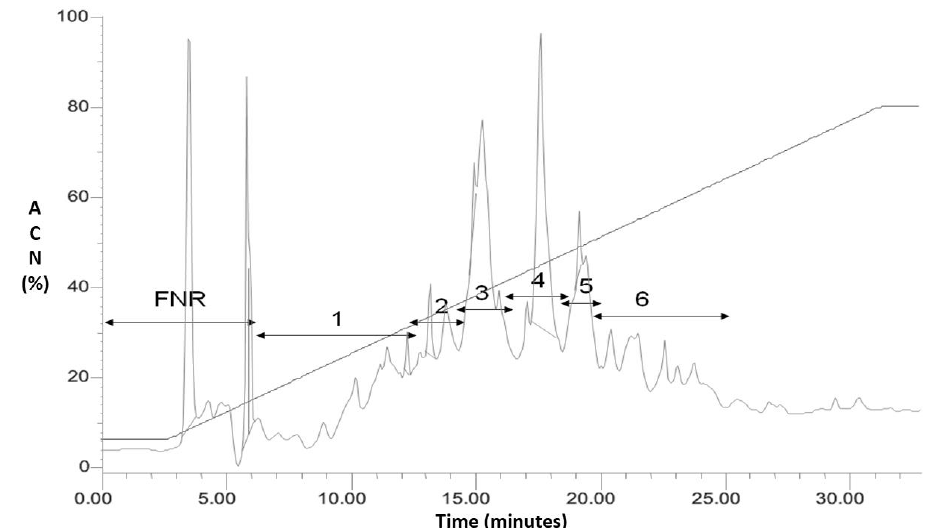
Figure 1. RP- HPLC of the dialyzed fraction (>1 kDa) of L. latrans . Detection 220 nm. FNR: fraction not retained; 1 – 6: fractions collected.